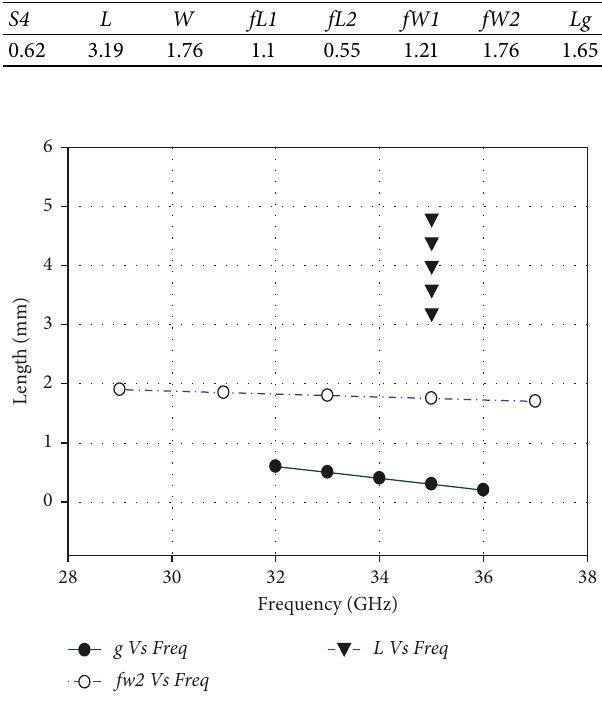
Figure 5: Variation of parameters “ g ”, fw2